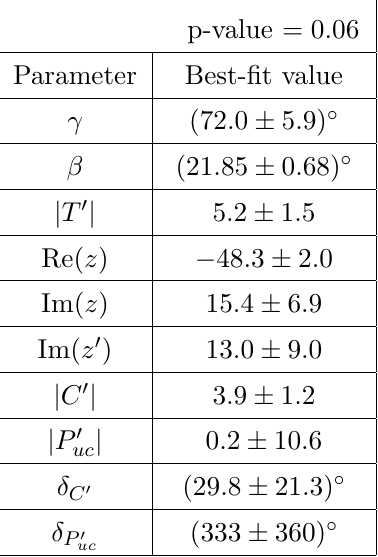
is nonzero. Constraints: B ! (cid:25)K NP